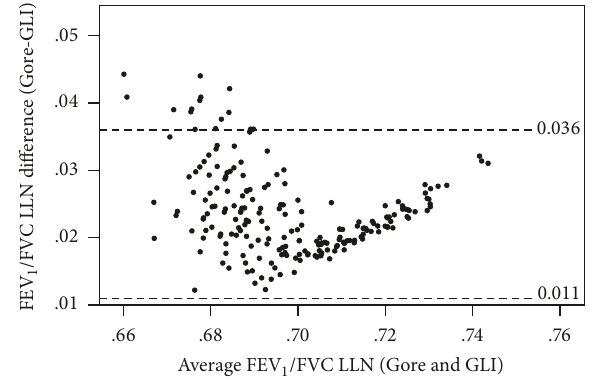
Figure 4: Differences between the LLN FEV 1 /FVC ratio for Gore compared with GLI illustrating the systematic difference at higher values ( 𝑁 =